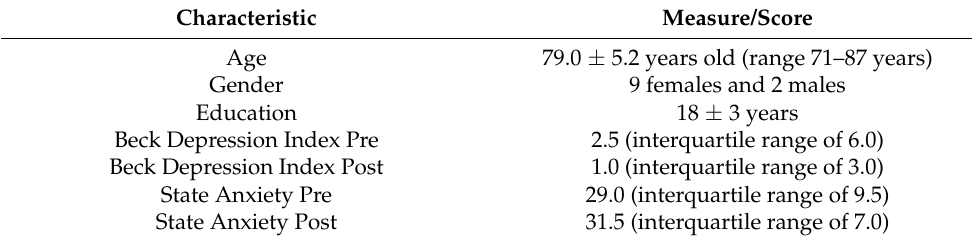
Table 1. Patient demographics and pre/post clinical